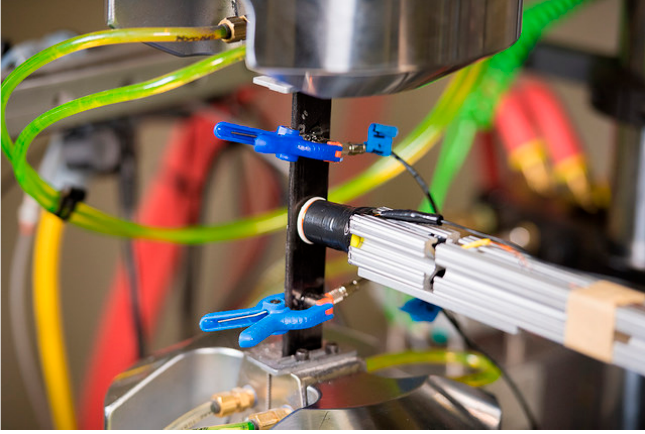
Figure 2. Magnetostrictive carbon fiber reinforced polymer. Quasi static Tension-Tension